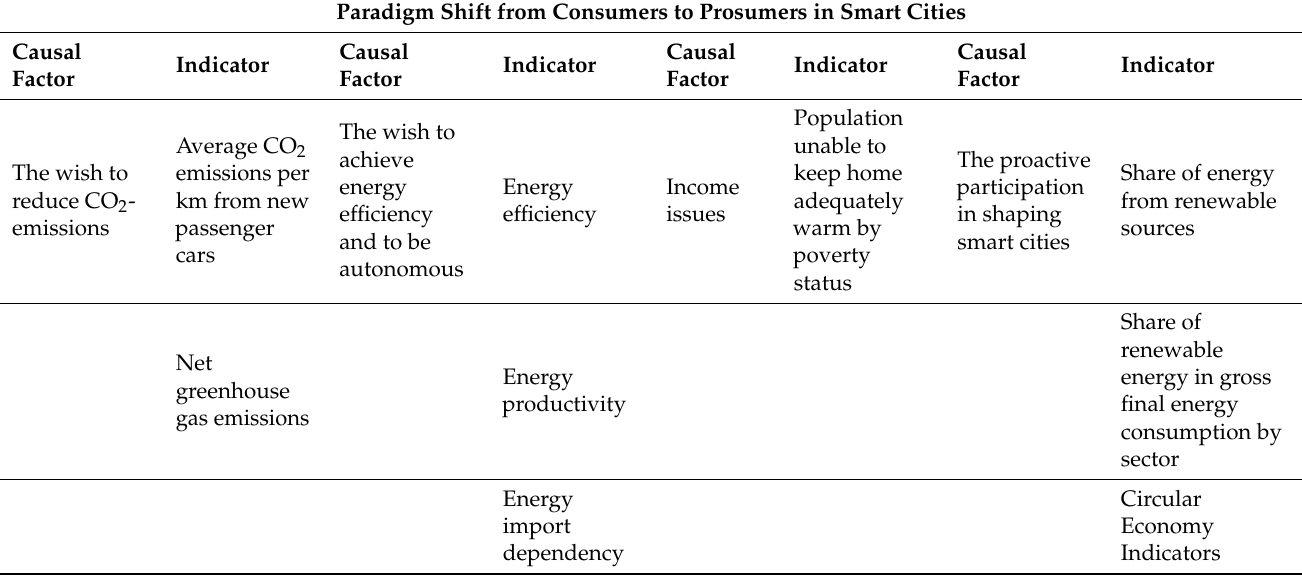
Table 1. Matrix—Paradigm shift from consumers to prosumers in smart